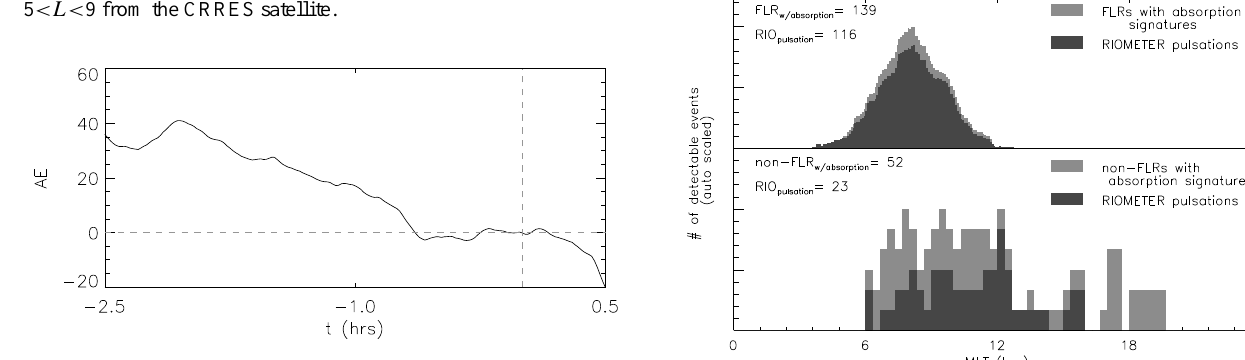
Fig. 7. Superposed epoch analysis for riometer Pc5 pulsation events for 1989–1995 (116 events). T=0 corresponds to the beginning of a pulsation event in the riometers.